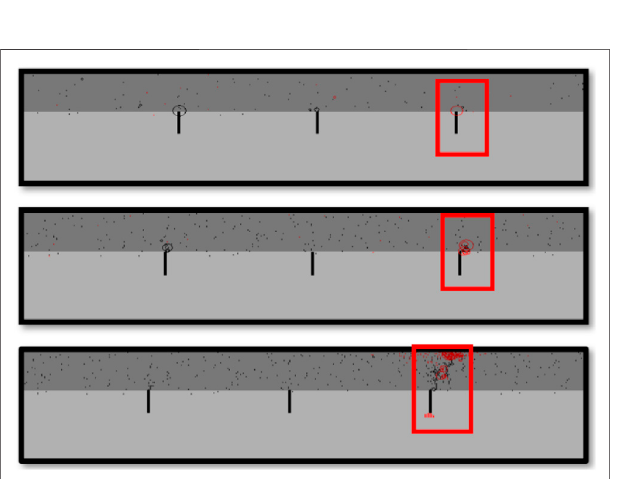
FIGURE 13 | Distribution of AE during formation of re fl ection cracks when S/T = 2.5.